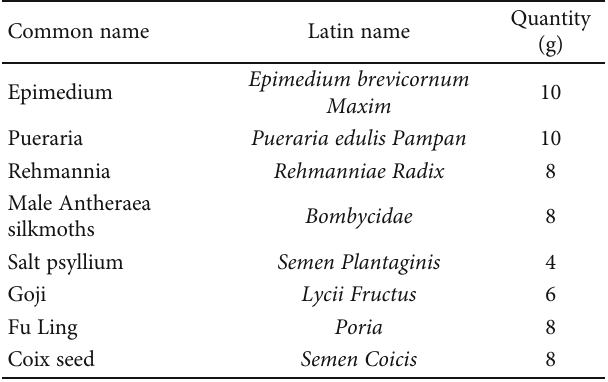
Table 1: Composition of